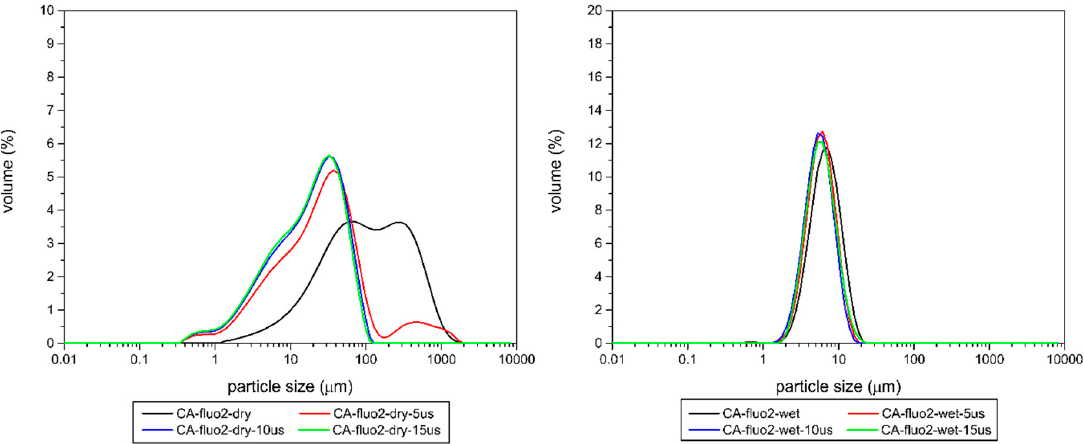
Figure 6. Comparative study of the particle size distribution using dried and wet sample material of sample CA-fluo2.